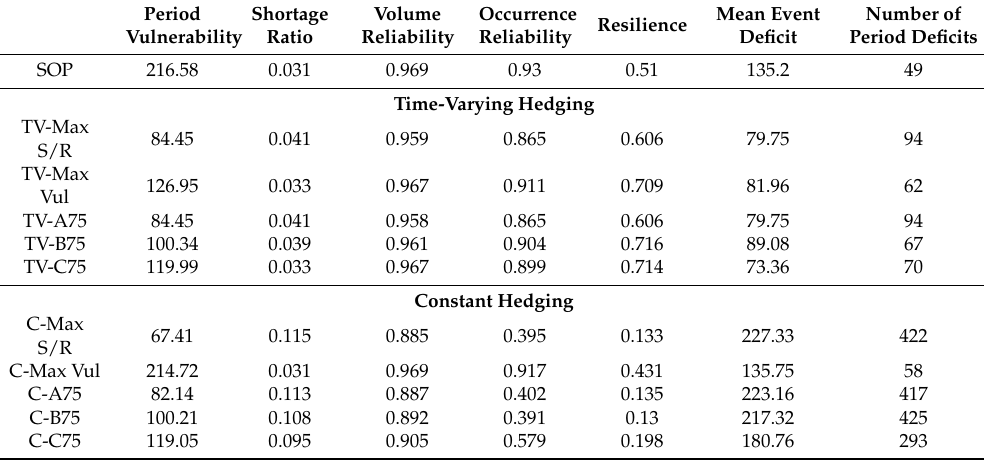
Table 5. Reservoir performance indices at 75% demand level for modified two point linear—a comparison of time-varying and constant hedging policies for selected compromising solutions (see figure